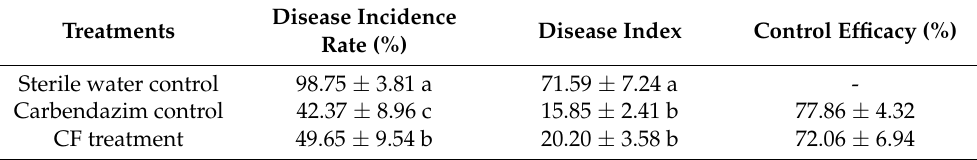
Table 3. Biocontrol efficacy of JK-25 on common root